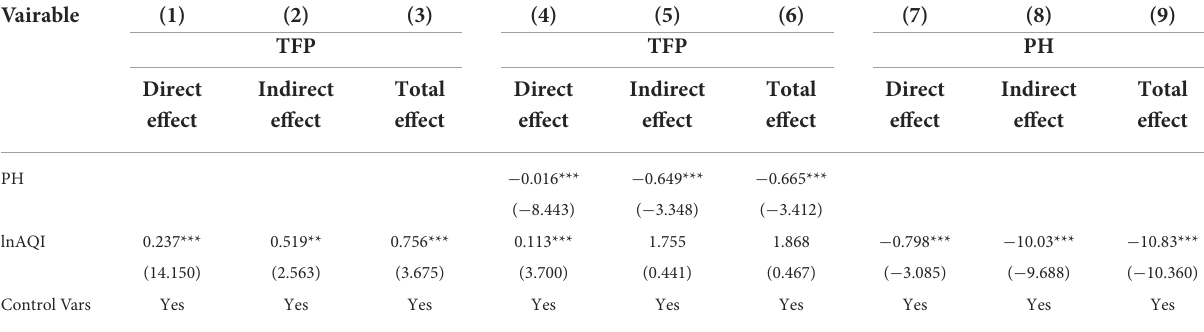
TABLE 18 Decomposition effect of resident health.